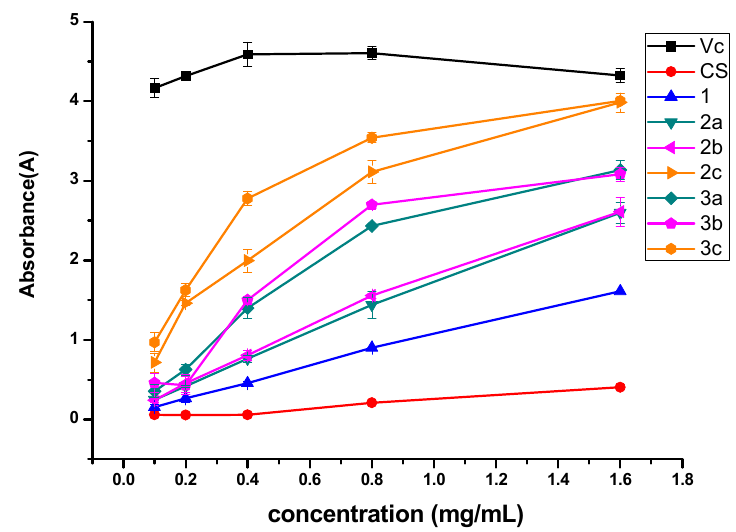
Figure 7. Reducing power of chitosan and chitosan derivatives.